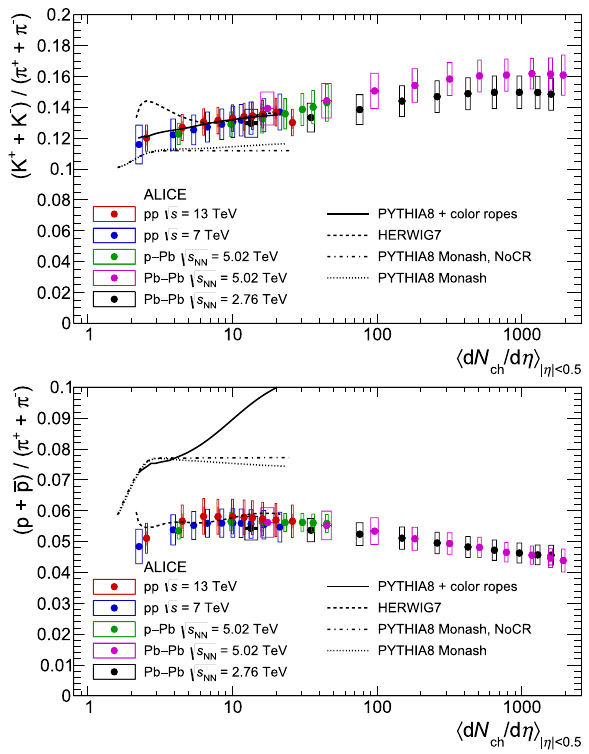
Fig. 5 Integrated K/ π (top) and p/ π (bottom) yield ratios as a func- tion of charged-particle multiplicity density measured in pp, p–Pb, and Pb–Pb collisions at different center-of-mass energies. Empty (shaded) boxes represent total (multiplicity uncorrelated) systematic uncertain- ties. Black lines represent predictions from different MC generators for √ s = 13 TeV. References from [11,25,33,50] pp collisions at